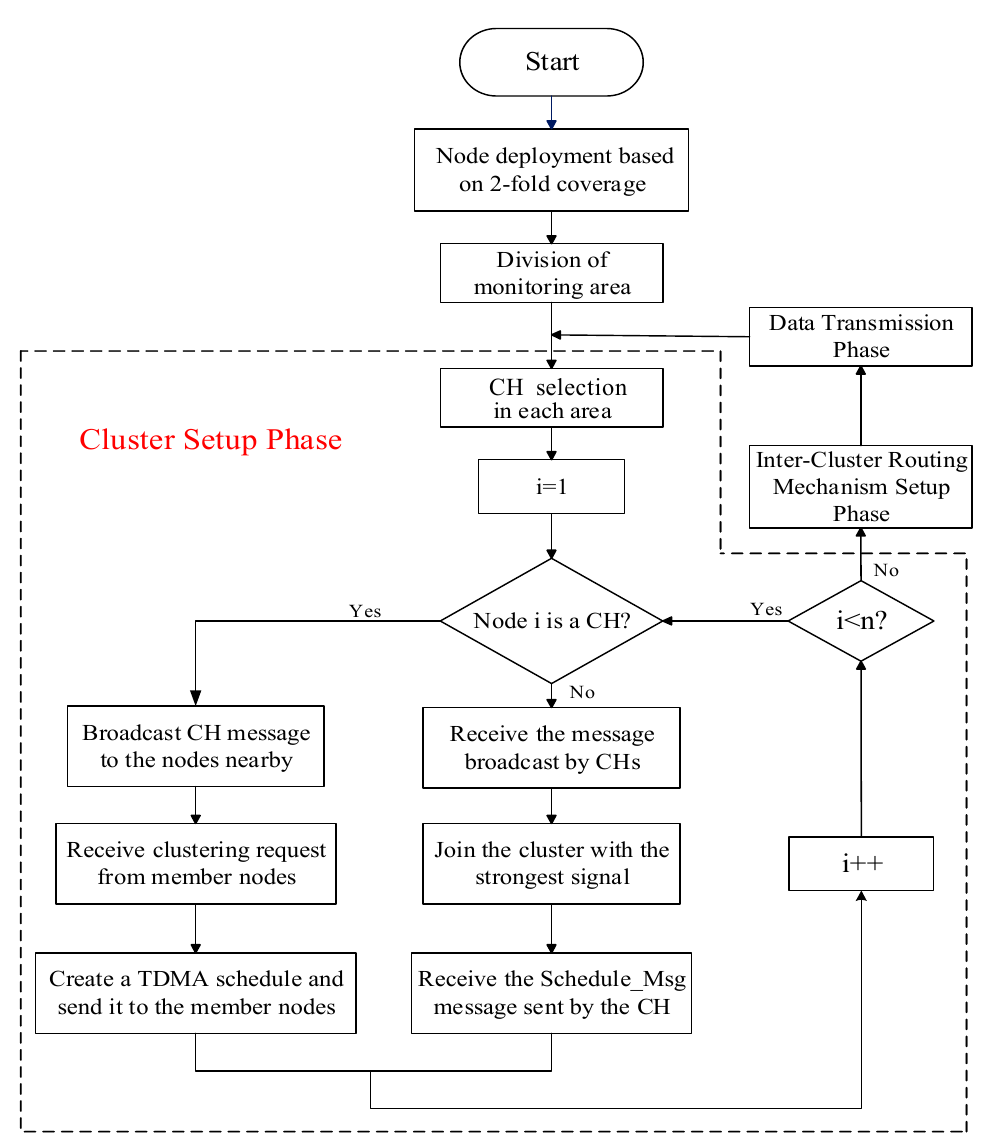
Figure 6. Flowchart of the clustering protocol, including node deployment, CHs selection, cluster setup, and data transmission.